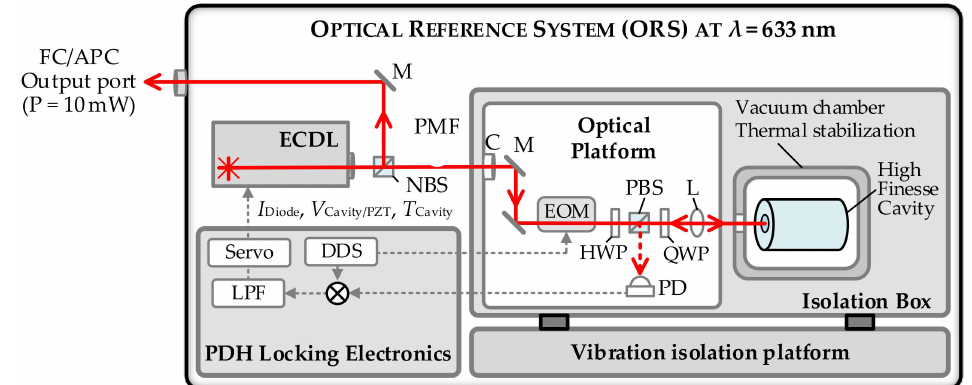
Figure 4. Structure of the ORS. The abbreviations denote: ECDL—external cavity diode laser, FC—fiber- coupled, NBS—neutral beam splitter, C—collimator, PMF—polarization-maintaining fiber, M—mirror, EOM—electro-optic modulator, HWP—half wave plate, PBS—polarizing beam splitter, QWP—quarter wave plate, L—lens, DDS—direct digital synthesizer, LPF—low pass filter. The red lines indicate optical path lengths, the dashed gray lines electronic signals. The light of the ECDL is sent through a phase- modulator operating at 20 MHz to generate sidebands for the PDH-lock. The 20-MHz reference signal is provided by a DDS. The error signal is created by mixing the signal from the photodetector containing the reflected light from the cavity with the signal from the DDS and subsequent low-pass filtering. The frequency of the laser is stabilized via fast feedback to the current and slow feedback to the piezo-electric actuator controlling the external cavity length of the diode laser [65].